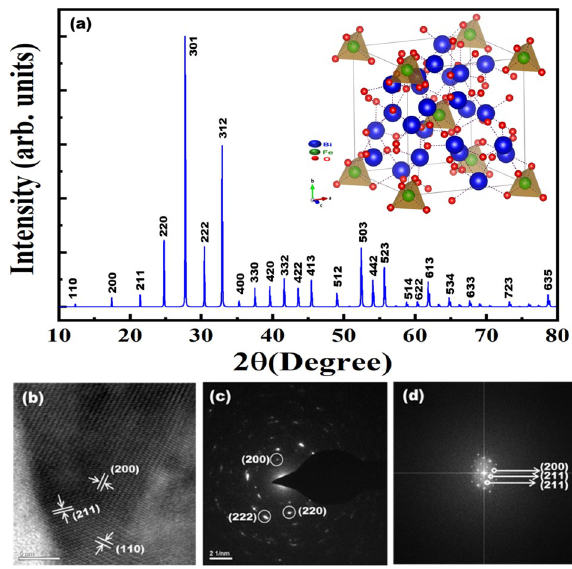
Figure 1. ( a ) Single crystal XRD pattern of Bi 12 FeO 20 (inset crystal structure of Bi 12 FeO 20 comprising of body- centered cubic FeO